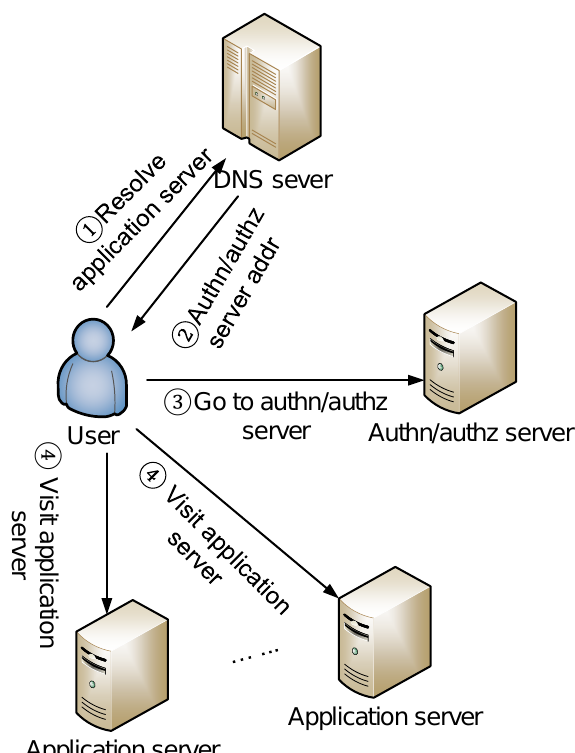
Figure 9. DNS Service Mutation